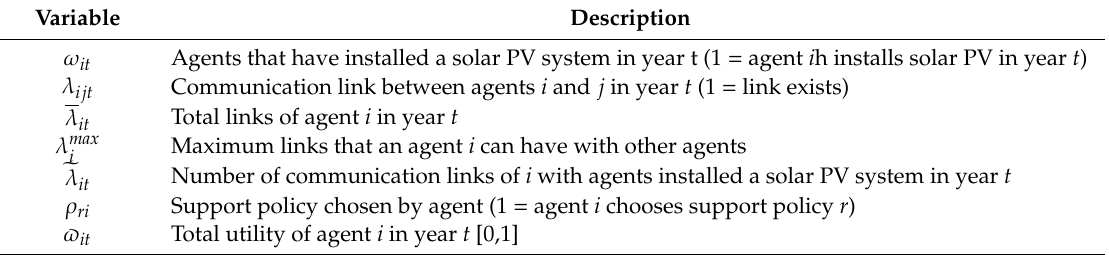
Table A10. Endogenous variables used in the mathematical description of the